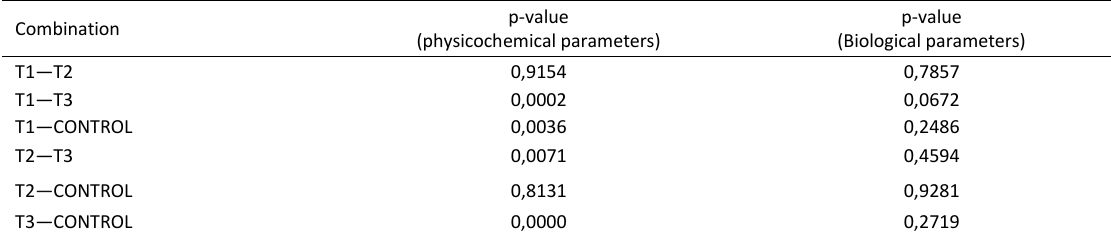
Table 3: Probability value at a statistical significance level of 95%